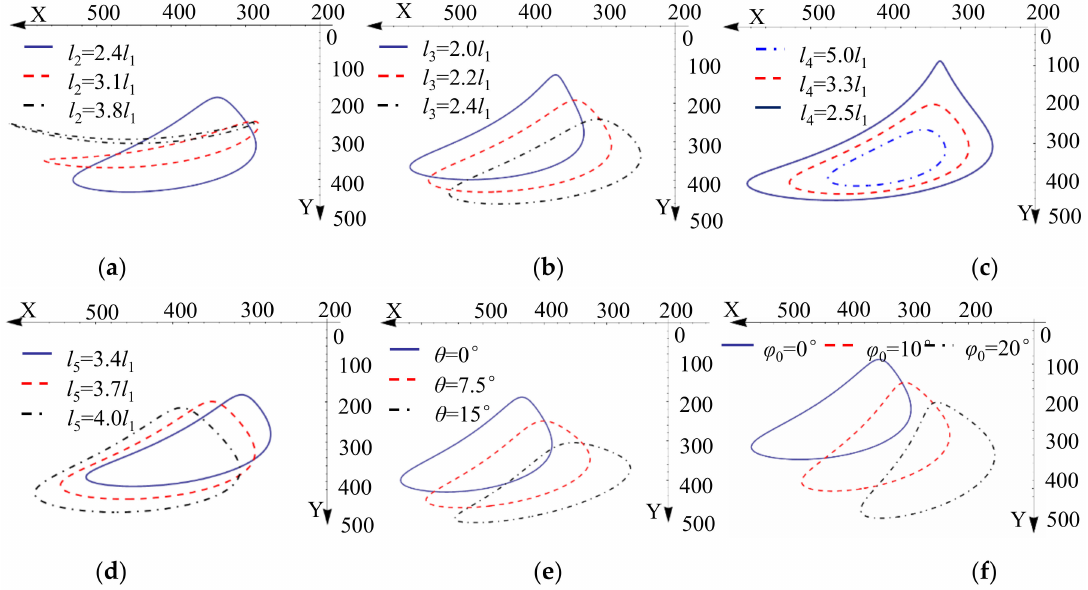
Figure 5. Influence of parameters on the trajectory E ( x , y ). ( a ) Relationship between l 2 and the trajectory; ( b ) relationship between l 3 and the trajectory; ( c ) relationship between l 4 and the trajec- tory; ( d ) relationship between l 5 and the trajectory; ( e ) relationship between θ and the trajectory; ( f ) relationship between ϕ 0 and the trajectory.